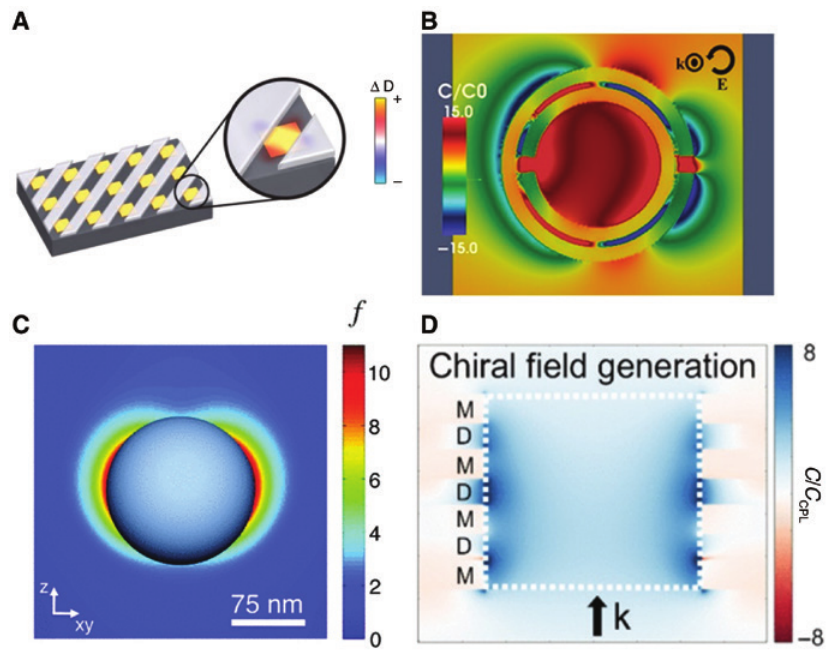
Figure 4: The optical chirality enhancement in the vicinity of various achiral metamaterials and nanostructures: (A) a gold nanopatch array with a cover layer [12], (B) an achiral split ring resonator [47], (C) a silicon nanoparticle [46], and (D) a double fishnet structure